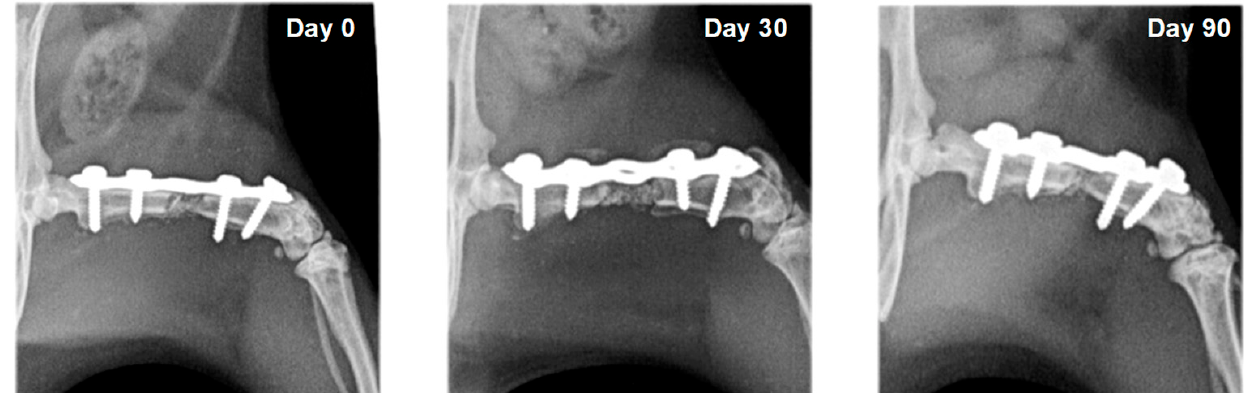
Figure 8. Serial craniocaudal radiographs of rat femurs from experimental group F6 on post-operative days 0, 30 and 90.